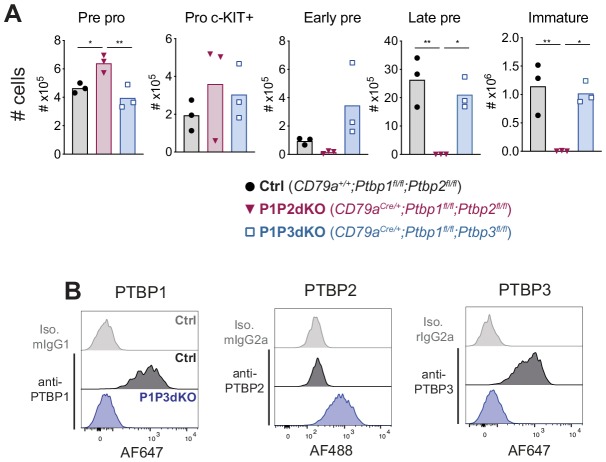
Deletion of Ptbp1 and Ptbp3 results in normal B cell development in the bone marrow.(A) Numbers of distinct developmental B cell stages in the bone marrow (two femurs) from mice with the indicated genotypes identified as: Pre-pro (IgD- IgM- B220+ CD43+ CD19-), Pro cKIT+ (IgD- IgM- B220+ CD43+ CD19+ cKIT+ CD25- CD2-), Early pre-B cells (IgD- IgM- B220+ CD43+ CD19+ CD25+ CD2+), Late pre (IgD- IgM- B220+ CD43- CD19+) and Immature (IgD- IgM+ B220+) B cells. Bars depict arithmetic means, each point represents data from an individual mouse and P-values were calculated by one-way ANOVA with Tukey's multiple comparisons test. Summary adjusted p value *<0.05, **<0.01, ***<0.001, ****<0.0001. Adjusted p values between P1P3dKO and control late pre-B cells and immature B cells were 0.5617 and 0.8592, respectively. Data shown are from one experiment. (B) PTBP1, PTBP2, PTBP3 and isotype control staining of pro-B cells B cells (IgD- IgM- B220+ CD19+ CD43high CD2-) from control mice (CD79a+/+;Ptbp1fl/fl;Ptbp2fl/fl) and P1P3dKO (CD79aCre/+;Ptbp1fl/fl;Ptbp3fl/fl) mice analysed by flow cytometry. Data shown are from one mouse representative of three individual mice analysed in one experiment.